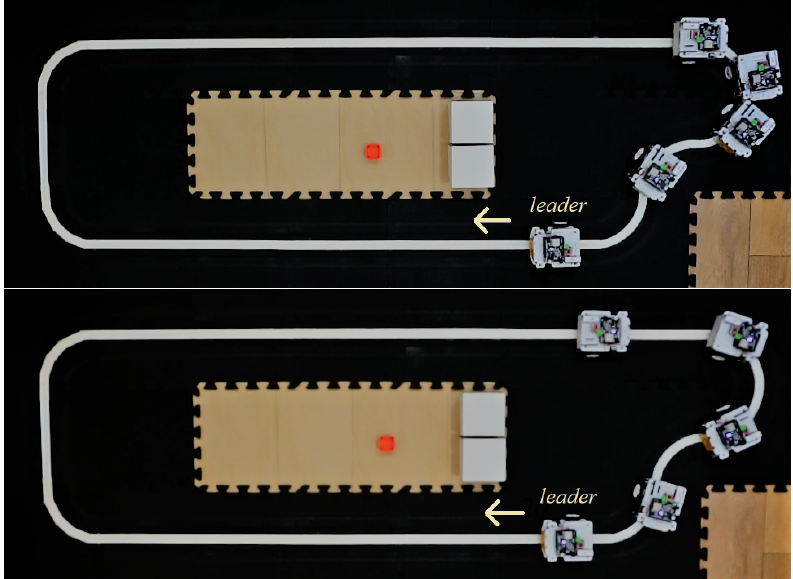
Figure 16. Visual comparison of the performance with the non-cooperative case ( top ) and the cooperative case ( bottom